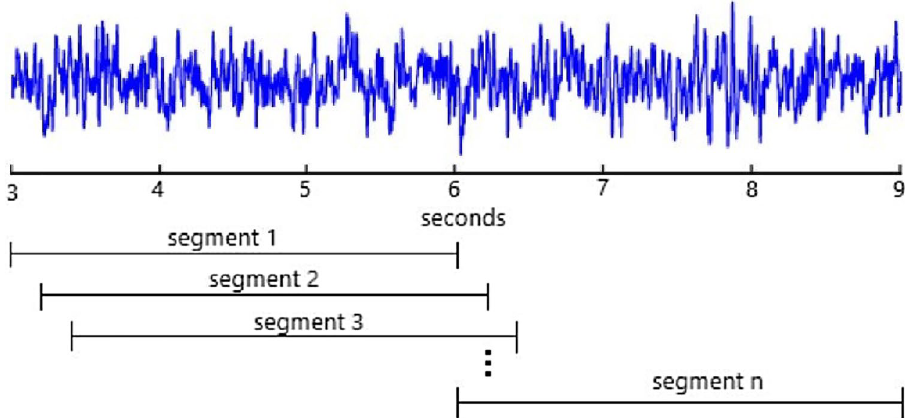
Figure 9. Demonstration of three-second segments of dataset II–III with a stride of 250